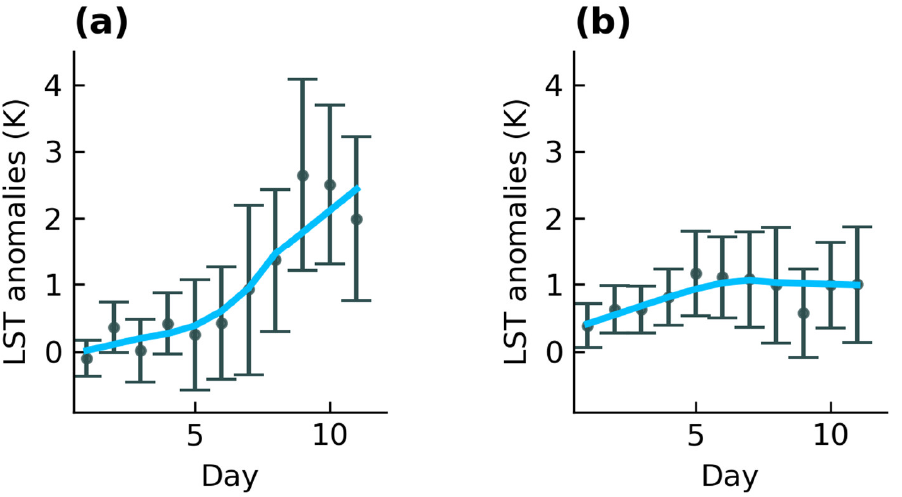
Figure 10. As in Figure 9, for Aqua/MODIS (MYD11A1).